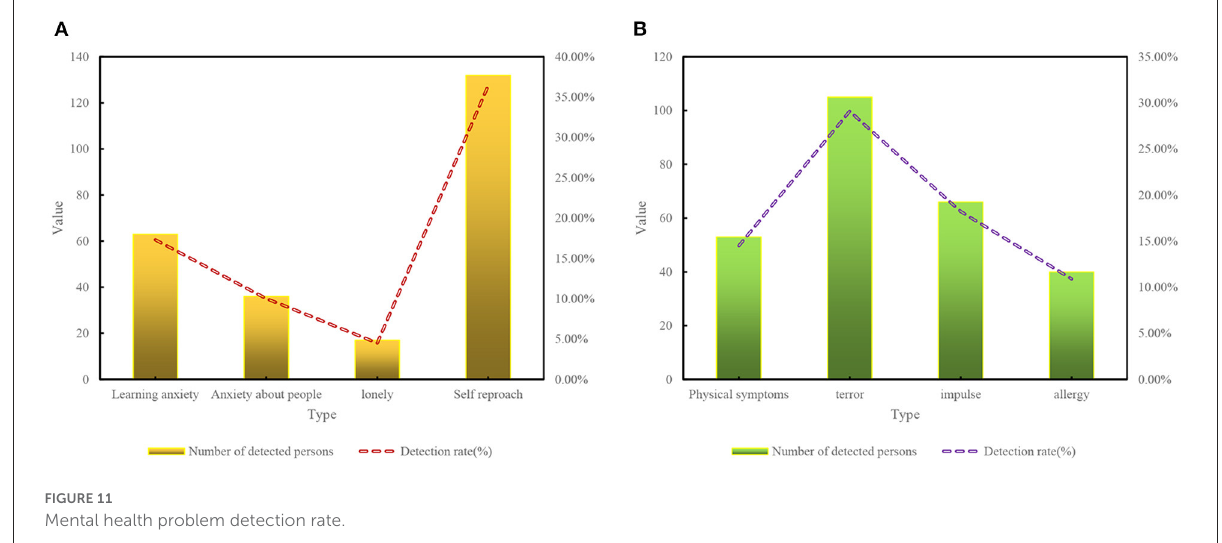
FIGURE11 Mental health problem detection